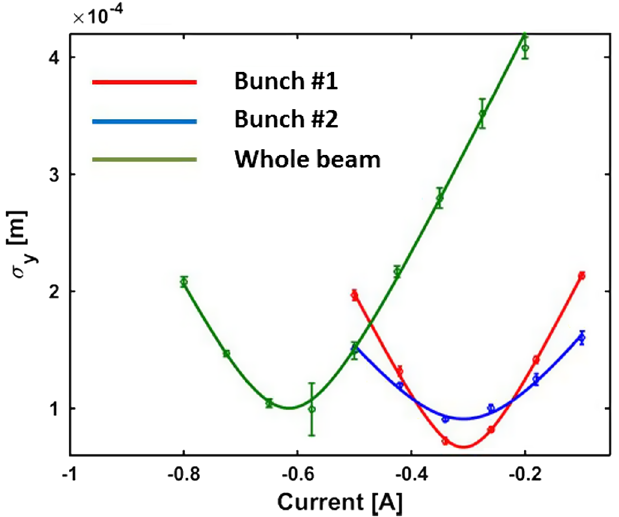
FIG. 4. Emittance measurement in the vertical plane on screen D1 and on screen U3. The single bunches are measured on D1 and the whole on